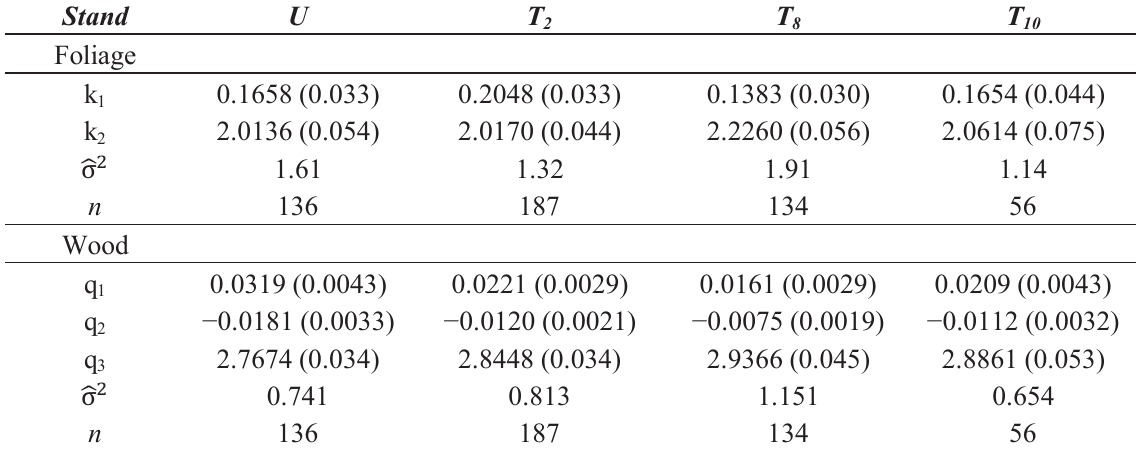
Table 3. Parameter estimates with standard errors for the branch foliage biomass model (1) and for the branch wood biomass model (2) by treatment, with weighted mean squared